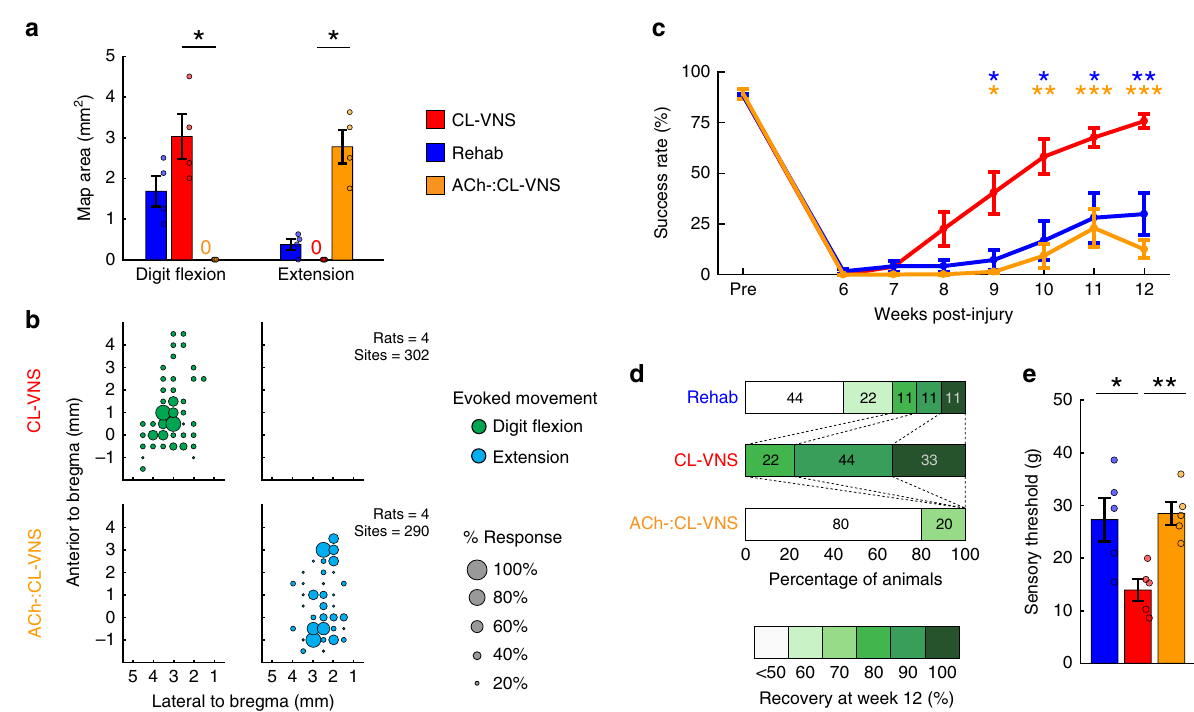
Fig. 5 Depleting acetylcholine in the brain prevents the reversal of pathological plasticity and blocks motor and sensory recovery after nerve injury. a Depletion of acetylcholine in rats that receive equivalent VNS paired with rehabilitation (ACh-:CL-VNS, n = 4) blocks the VNS-dependent restoration area of motor cortex evoking movements of the denervated digit fl exors (CL-VNS, n = 4; Rehab, n = 4). Additionally, CL-VNS reverses the aberrant expansion of evoked extension movements, while acetylcholine-depleted subjects display an enduring expansion of extension representations. Compare to Fig. 2. b Bubble plots displaying the cortical locations of digit fl exion and extension movements across all animals in each experimental group. The size of each bubble represents the proportion of subjects for which ICMS evoked digit fl exion or extension movements at each cortical site. Note that depletion of acetylcholine prevents CL-VNS-dependent restoration of digit fl exion representations and also prevents the reduction of extensor representations. Same group sizes as in a . c Consistent with blocking the reversal of pathological plasticity, depletion of acetylcholine prevents the VNS-dependent enhancement of recovery of motor function after nerve injury (Rehab, n = 9; CL-VNS, n = 9; ACh-:CL-VNS, n = 5). d ACh-:CL-VNS subjects exhibit substantially reduced levels of motor recovery compared to CL-VNS. Same group sizes as in c . e Depletion of acetylcholine also prevents VNS-dependent recovery of tactile thresholds (Rehab: n = 5; CL-VNS: n = 5; ACh-:CL-VNS: n = 5). Circles depict individual subjects in panels ( a , e ). In c asterisks indicate signi fi cant differences using t-tests across groups at each time point, and the color of the asterisk denotes the group compared to CL-VNS. All comparisons represent Bonferroni-corrected t -tests to CL-VNS, *** p < 0.0005, ** p < 0.005, * p < 0.025. Source data are provided as a Source Data fi